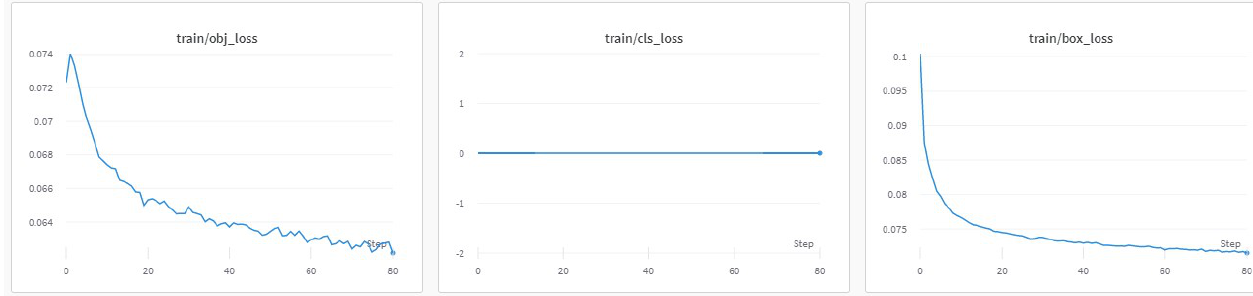
Figure 10. Training set metrics.